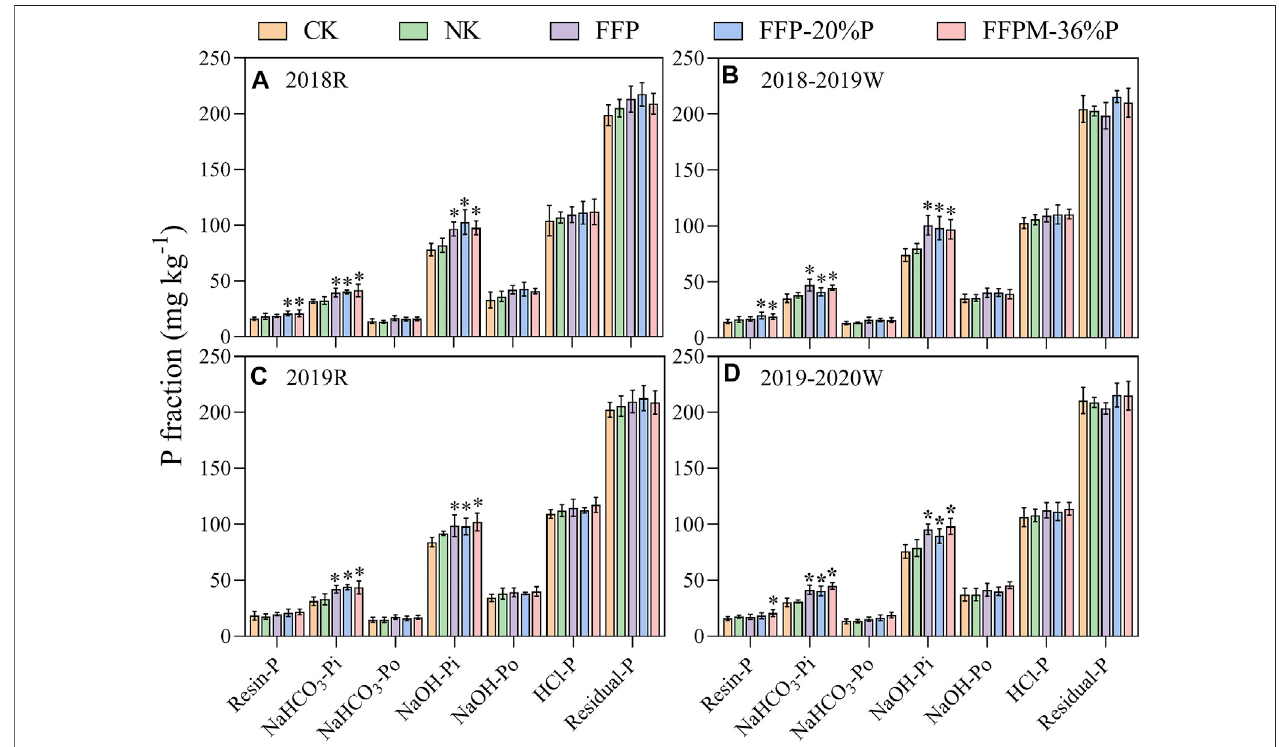
FIGURE 3 | Variations in sequentially extracted P fractions under optimized fertilization on two-year rice-wheat rotation paddy fi eld from 2018 to 2020.